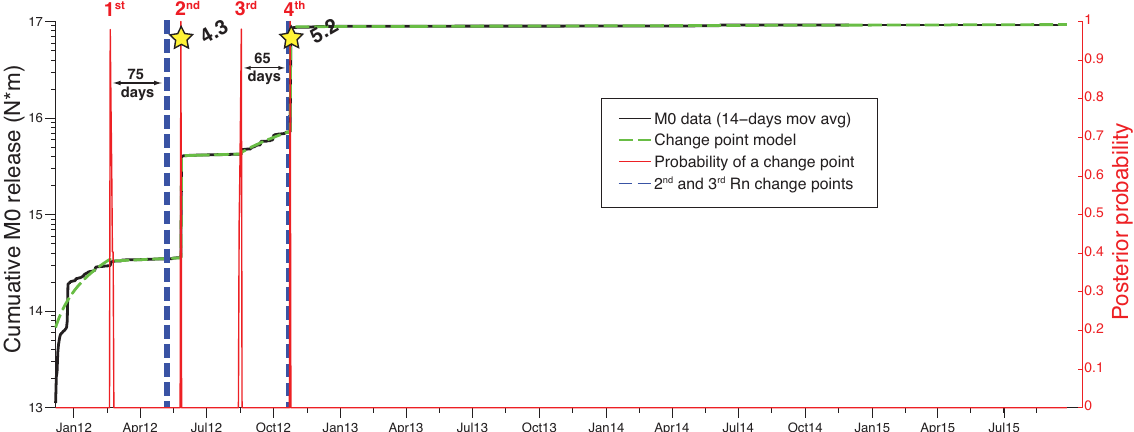
Figure 9. Change point analysis applied to cumulative seismic moment release. The black solid line represents the cumulative seismic moment release filtered with a 14-day moving average, while the green dashed line represents the model predicted by the BCP algorithm. The red curve indicates the probability of a change point at each time. The two blue dashed vertical lines mark the occurrence of the second and of the third change point represented in Fig. 8. Yellow stars represent the occurrence of the earthquakes Mw4.3 on 28 May 2012 and Mw5.2 on 25 October